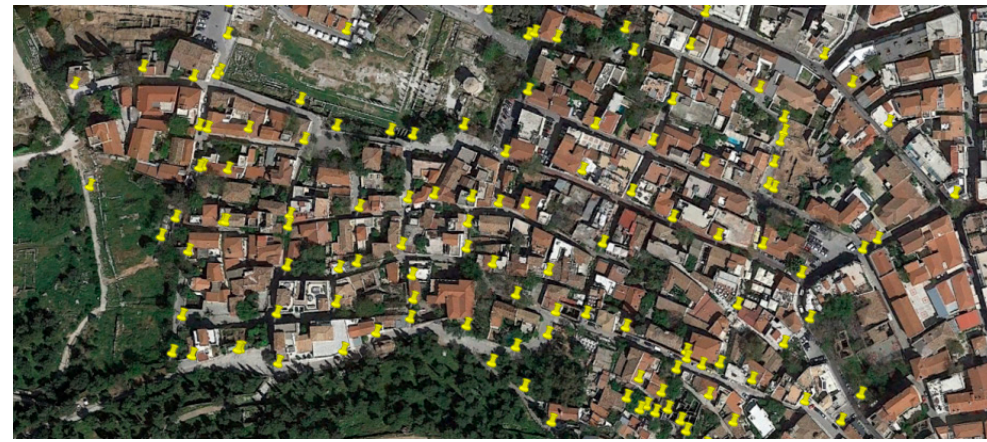
Figure 6. Ground Control Point (GCP) distribution.